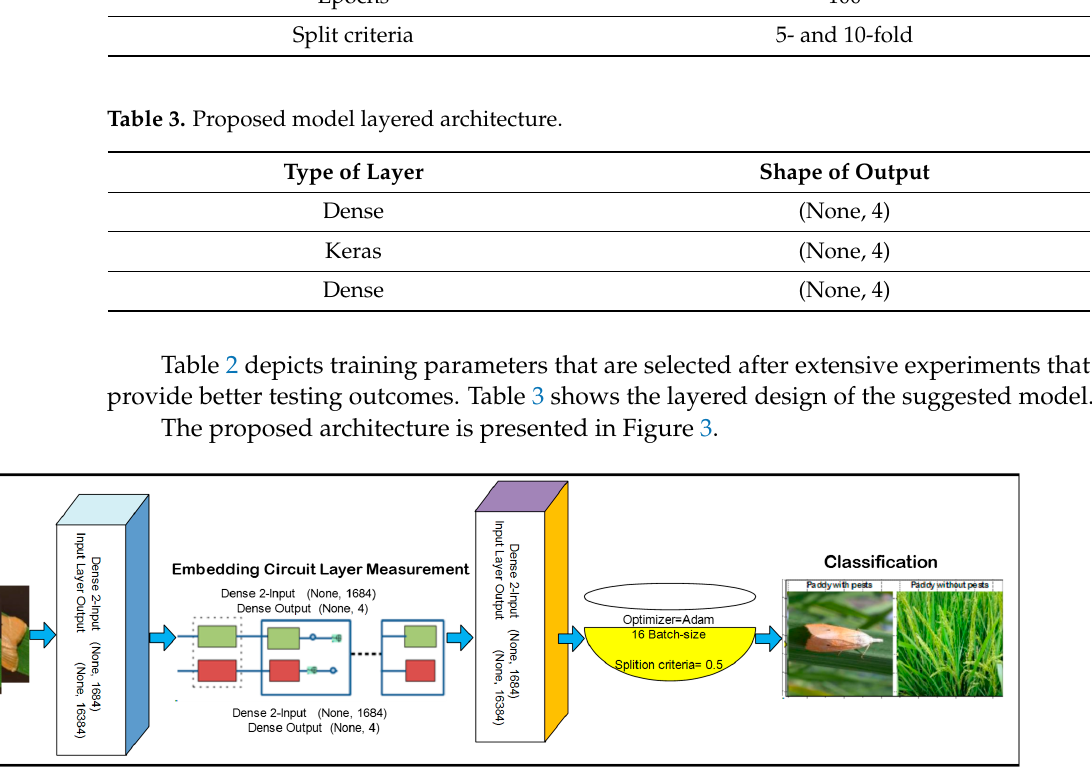
Table 2. Training parameters of the proposed model.